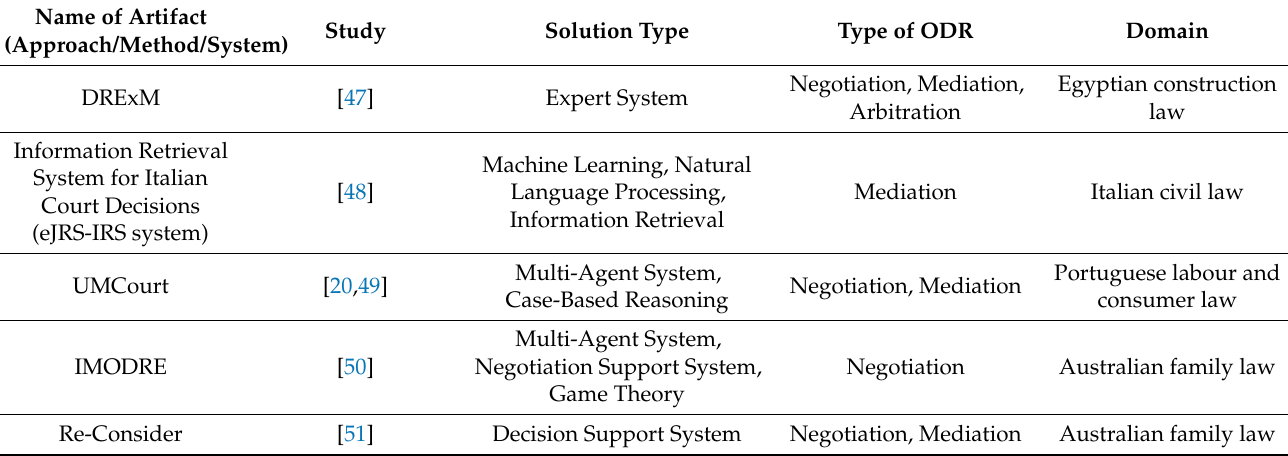
Table 2. Overview of different ODR artifacts using AI techniques.